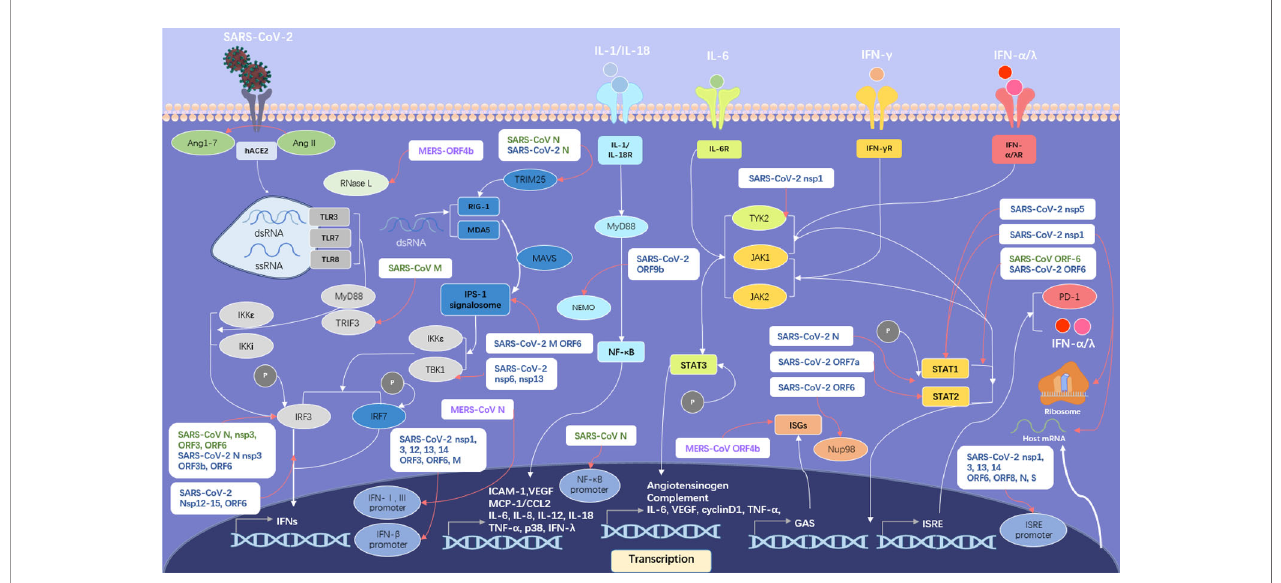
FIGURE 4 | SARS-like CoVs including SARS-CoV, MERS-CoV and SARS-CoV-2 inhibit host IFN signalling pathway. Proteins of SARS-CoV are in green, proteins of MERS-CoV in violet and proteins of SARS-CoV-2 in blue. The IFN upstream pathways are in the left side of the fi gure and the IFN downstream pathways are in the right side. The pattern diagram of SARS-CoV-2 is credited by Maria Voigt/RCSB